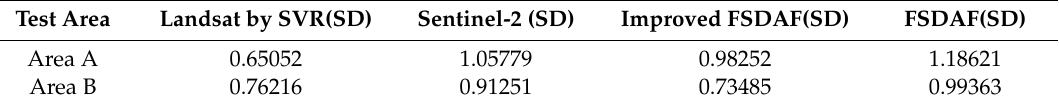
Figure 6. Correlation between the predicted LAI using different fusion models and Sentinel-2 LAI. ( a ) Improved FSDAF method; ( b ) FSDAF method. (red line is the 1:1 line). Table 2. Comparison of the standard di ff erence (SD) of LAI data from di ff erent